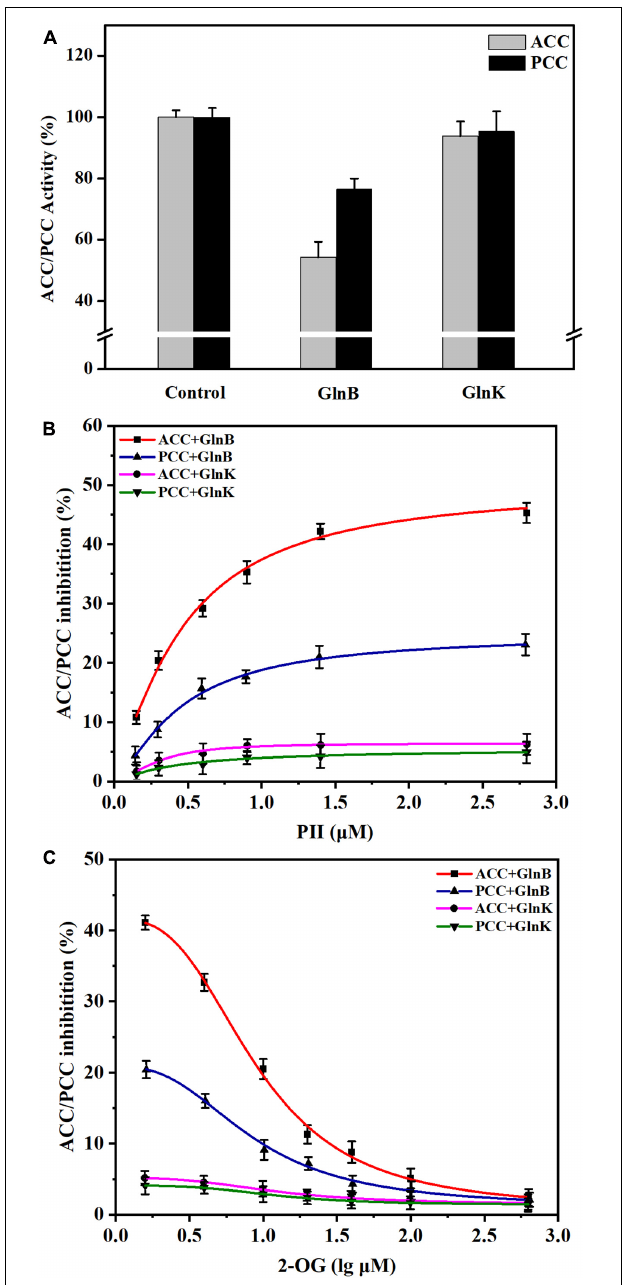
FIGURE 3 | Influence of PII proteins and 2-OG on the activity of acetyl-CoA carboxylase (ACC) and propionyl-CoA carboxylase (PCC) in vitro . (A) The changes of ACC and PCC activity in vitro caused by the addition of GlnB or GlnK protein. The enzyme activity in the reaction system without PII proteins was defined as 100%. The enzyme activity in the reaction system containing 5 µ M GlnB or GlnK protein was recorded for comparison. (B) The inhibition of ACC and PCC activity by PII proteins at different concentrations. The coupled enzyme activity assays were carried out in reaction systems without 2-OG. (C) Release of the inhibition of ACC and PCC by 2-OG at different concentrations. The coupled enzyme activity assays were performed in reaction systems including 3 µ M PII proteins. All data represent the mean values of three independent technical replicates, and the error bars represent the standard